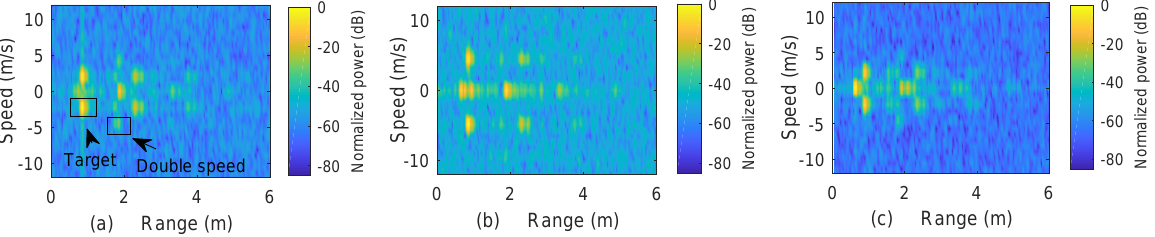
Figure 10. Range-speed plots for the speed measurements. ( a ) Range–speed plot of a single target moving with 2.34 m/s, whereas the moving assembler acts as a static unit. ( b ) Range–speed plot of the target in ( a ) with speed increased to 5 m/s. ( c ) Range–speed plot of a static target, placed at 0.6 m, and a moving target with speed of 2.34